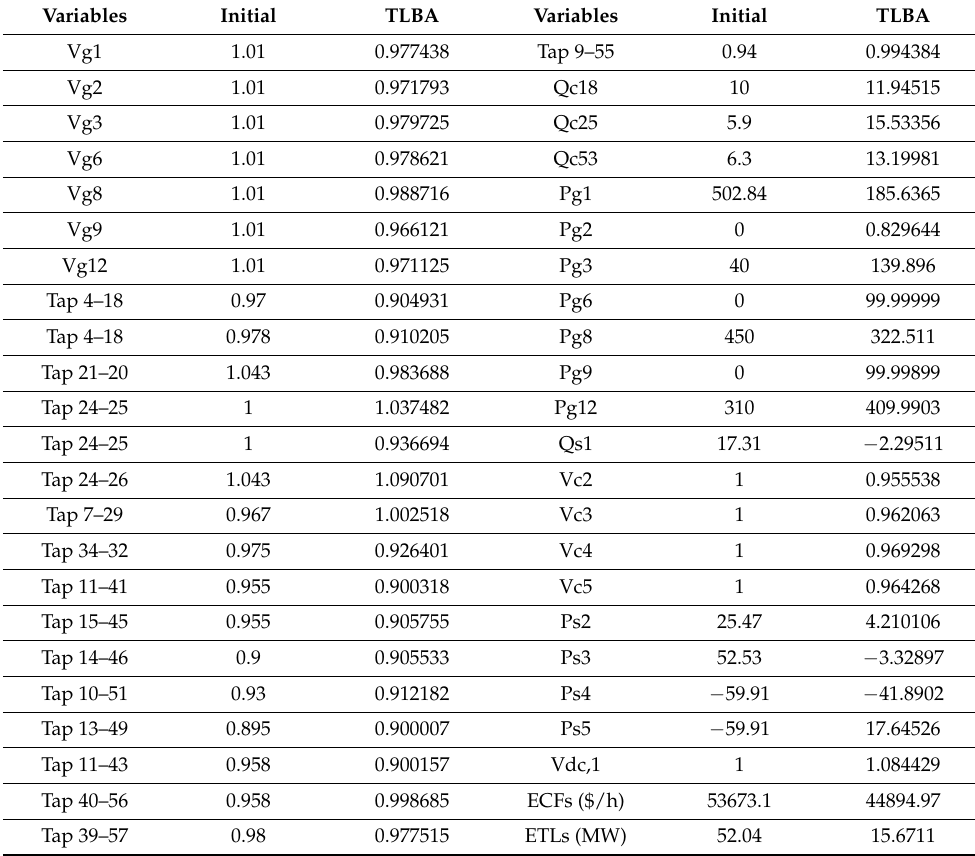
Table 9. Simulation results of TLBA for the minimization of the ETLs of the IEEE 57-bus network.